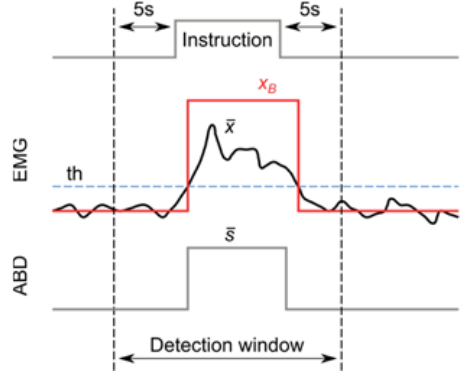
Figure 2. Depiction of the binarized signal x B obtained by thresholding the average EMG signal x and of the detection window used for comparing ABD and EMG events.